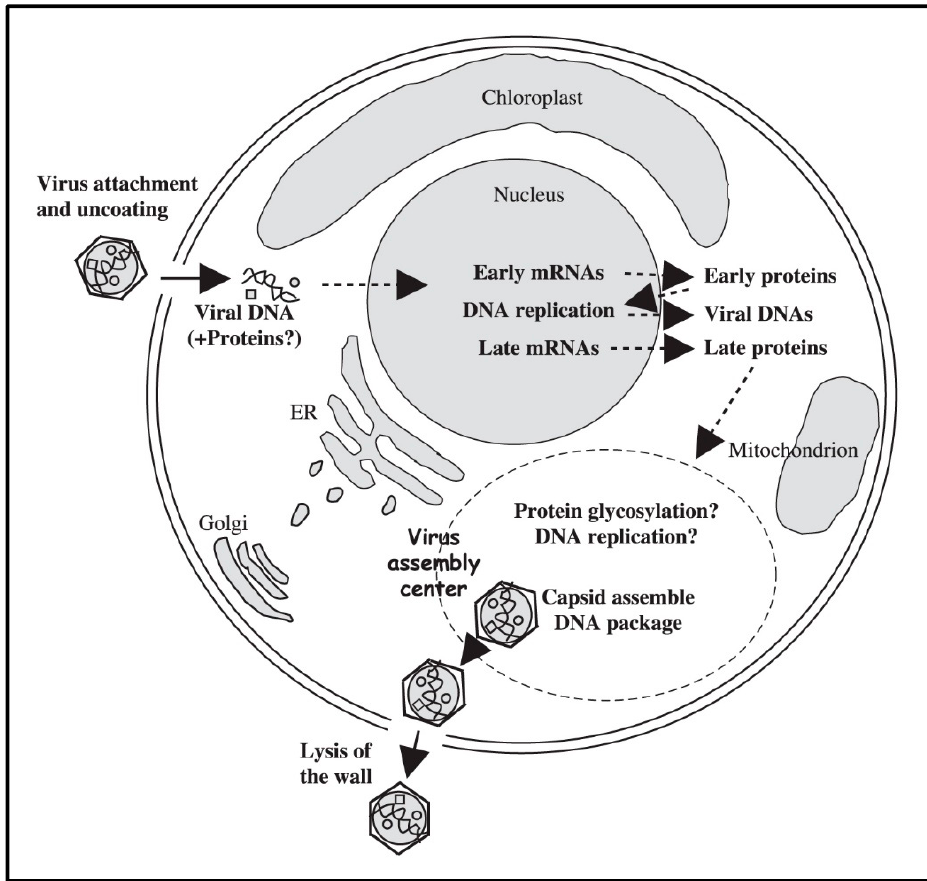
Figure 8. Proposed replication cycle of PBCV-1. The virus binds to the surface of the alga and opens a portal to release the viral DNA and associated proteins; the viral DNA moves to the nucleus where early gene transcription begins at 5 to 10 min p.i. Early mRNAs move to the cytoplasm for translation, and at least some early proteins presumably return to the viral genome located at or near to the nucleus to initiate viral DNA replication, which begins ~60 p.i., followed by late gene transcription. Late mRNAs move to the cytoplasm for translation and many of these late proteins are targeted to the virus assembly centers, where virus capsids are formed and DNA is packaged. Mature infectious virus particlles appear in the cytoplasm of the cell ~45 min prior to virus release. The chlorella cell membrane and wall lyses, and infectious PBCV-1 progeny viruses are released at 6 to 8 h p.i. ( → ) Known events; (- - - - > ) hypothesized events. Figure taken from Kang et al. [150] and used with permission.